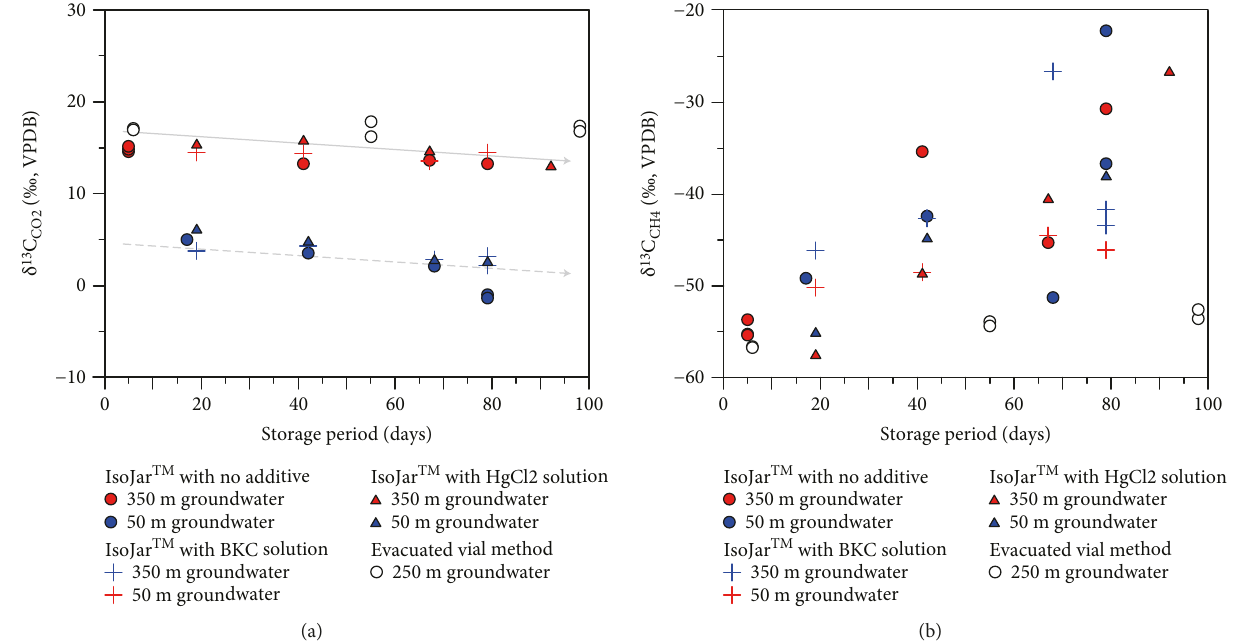
Figure 4: Temporal variations in (a) δ 13 C groundwater; dashed arrow indicates the trend for samples with 50 m groundwater.